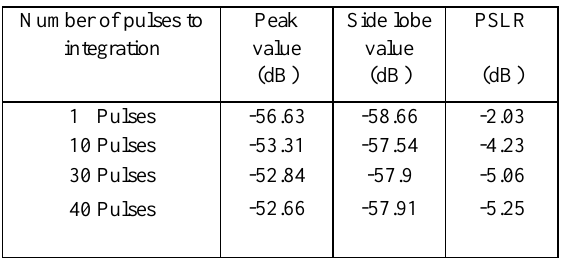
Table 2. PSLR results